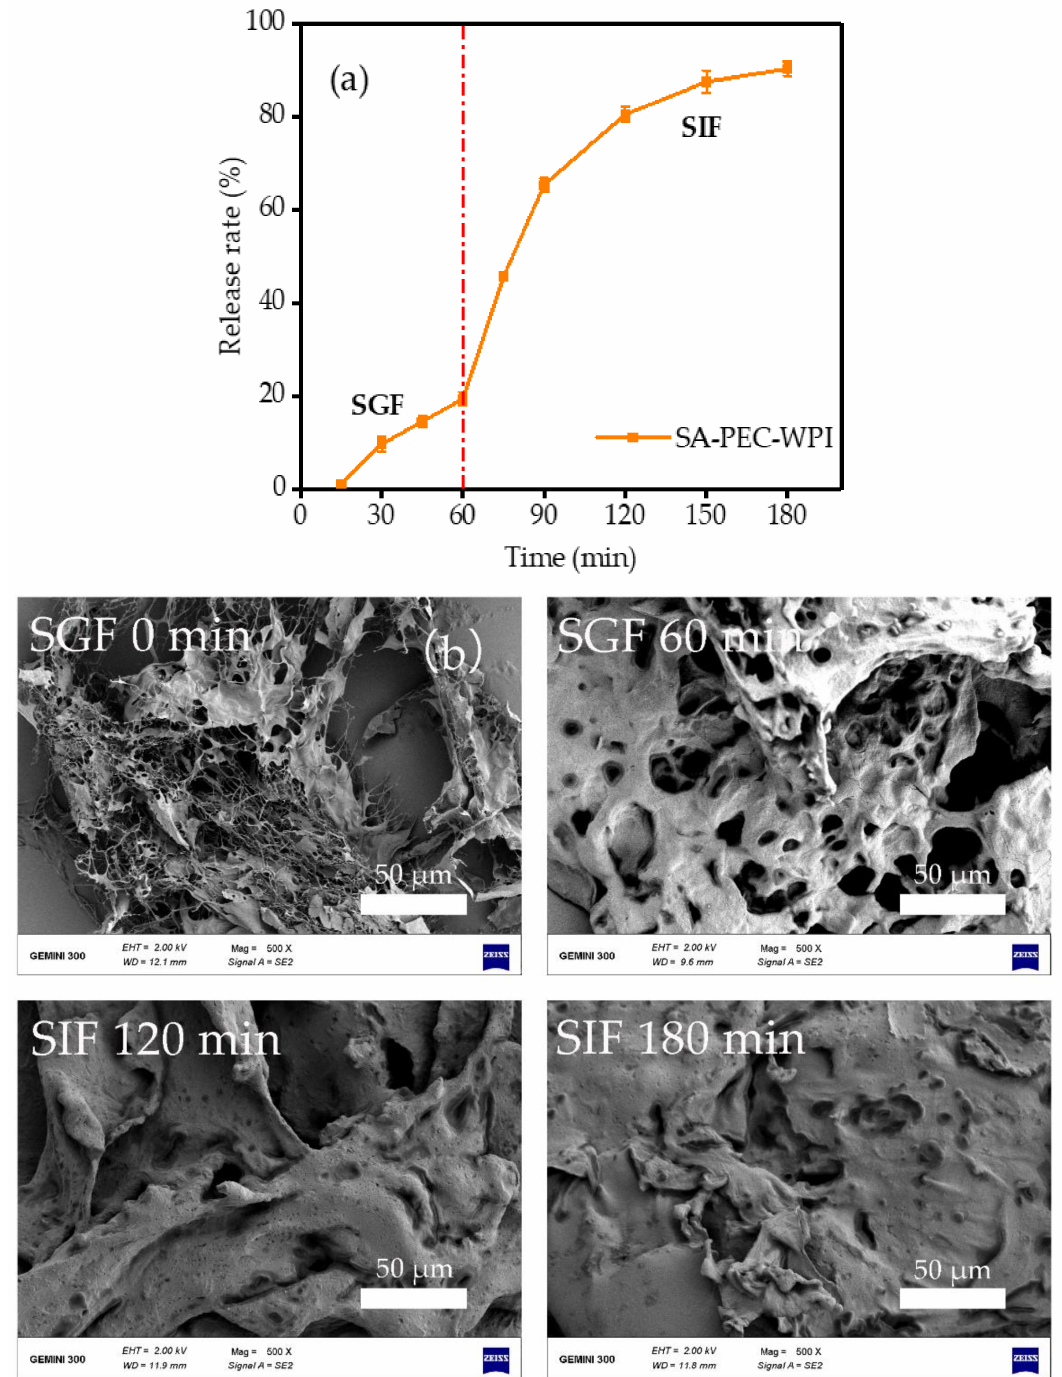
Figure 10. In vitro simulated digestion experiments. ( a ) The release rate of β -carotene from the SA-PEC-WPI stabilized β -carotene emulsion. ( b ) The SEM images of SA-PEC-WPI stabilized β -carotene emulsion at different digestion times. SEM: scanning electron microscope; SGF: simulated grastric fluid; SIF: simulated intestinal fluid; SA: sodium alginate; PEC: pectin; WPI: whey protein